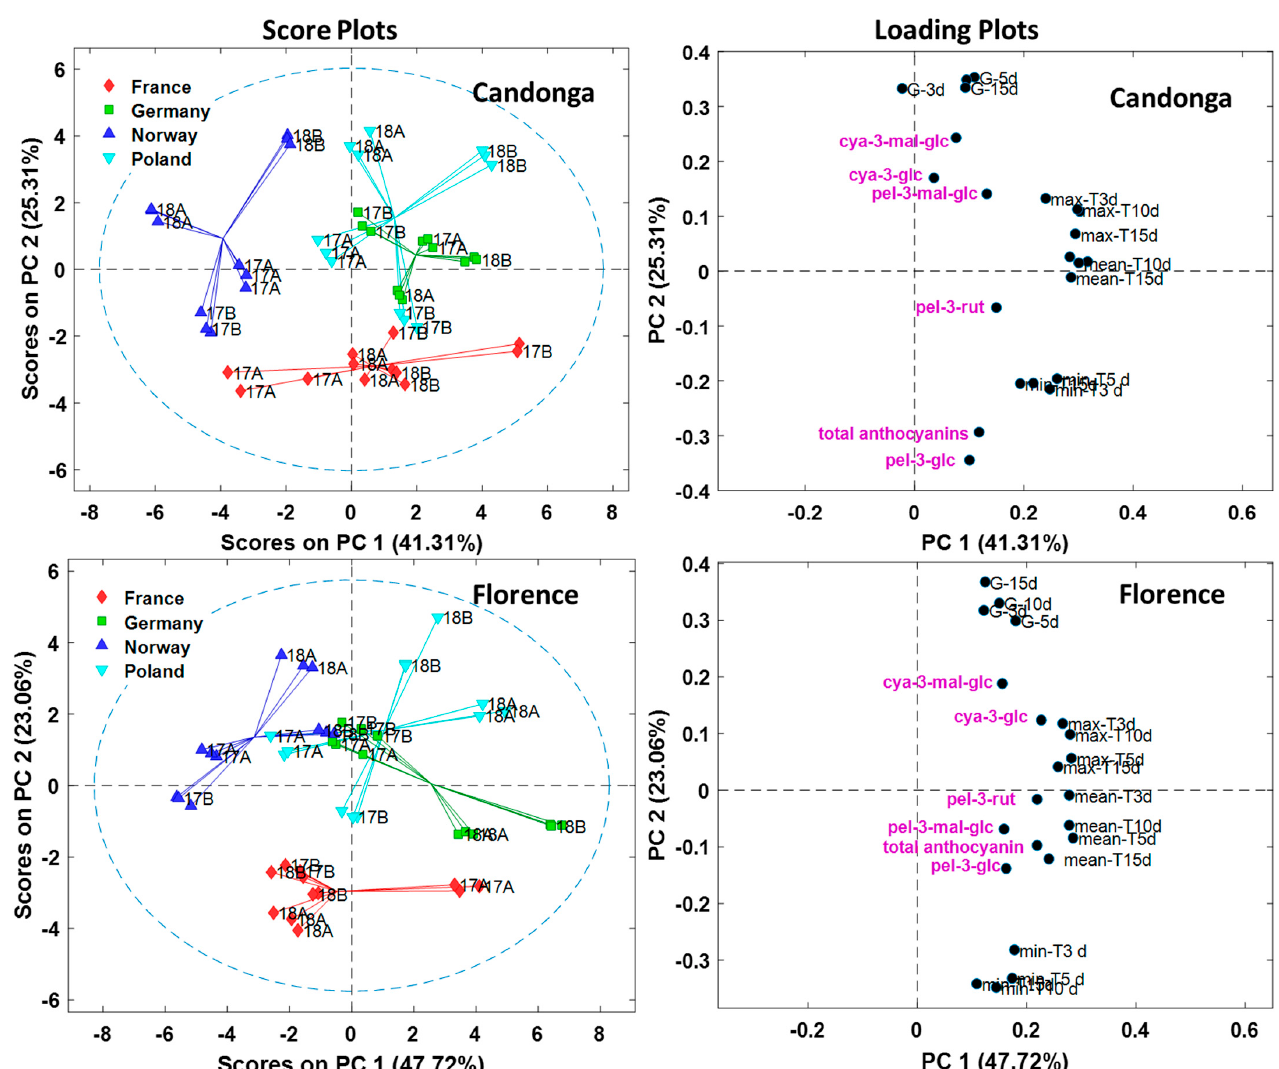
Figure 4. Score and loading plots of PCA for ‘Candonga’, and ‘Florence’ grown at four locations (F: France; G: Germany; N: Norway and P: Poland) characterized by total and individual anthocyanin and climatic data. The number and capital letters in the different panel are referring to the year (2017 and 2018, labeled as 17 and 18) and A or B to the harvest date, being one week apart.